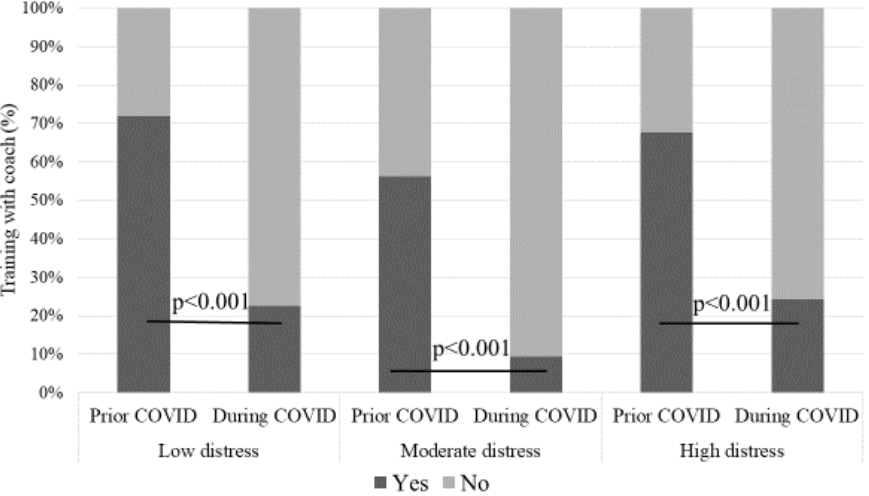
Figure 3. Training with a coach prior to and during the COVID-19 period in different study groups.